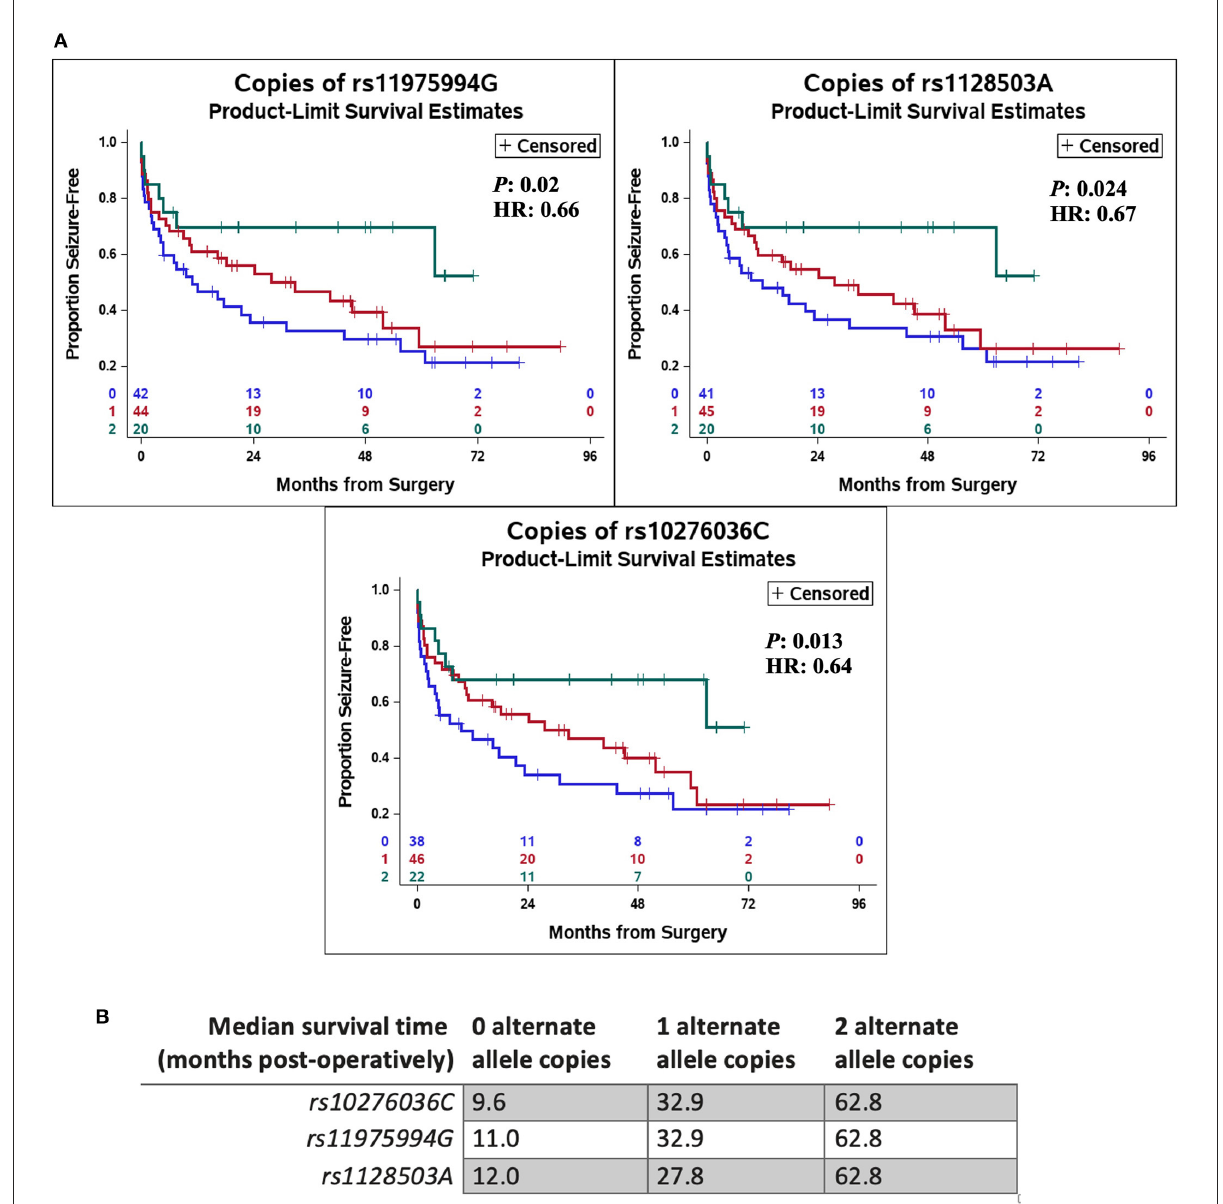
FIGURE2 Genetic variation in ABCB1 was associated with delayed recurrence of post-operative seizures. Kaplan Meier curves using a Cox proportional hazards model of each independent single-nucleotide polymorphism (rs10276036, rs1128503, rs11975994) depict the proportion of patients who remain seizure free after surgery by number of alternate allele copies (A) . The green line represents having two alternate allele copies, the red line represents having one alternate allele copy, and the blue line depicts having zero alternate allele copies. Hazard ratios (HR) and P -values ( P ) are displayed on each Kaplan Meier curve. (B) Shows the median time-to-seizure in months post-operatively for each SNP and number of alternate allele